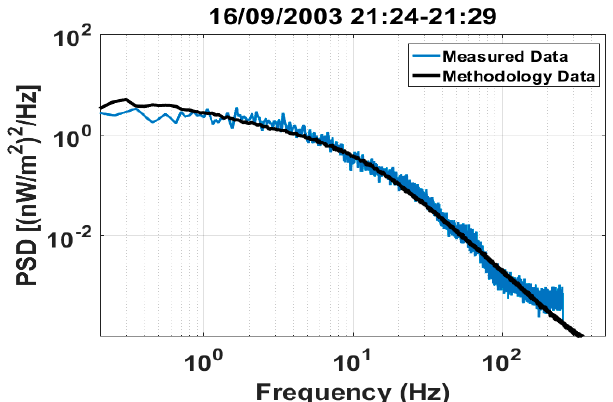
Figure 7. Second order irradiance statistics validation for session on 16/09/2003 21:10. PSD of measured data vs. PSD of generated data.